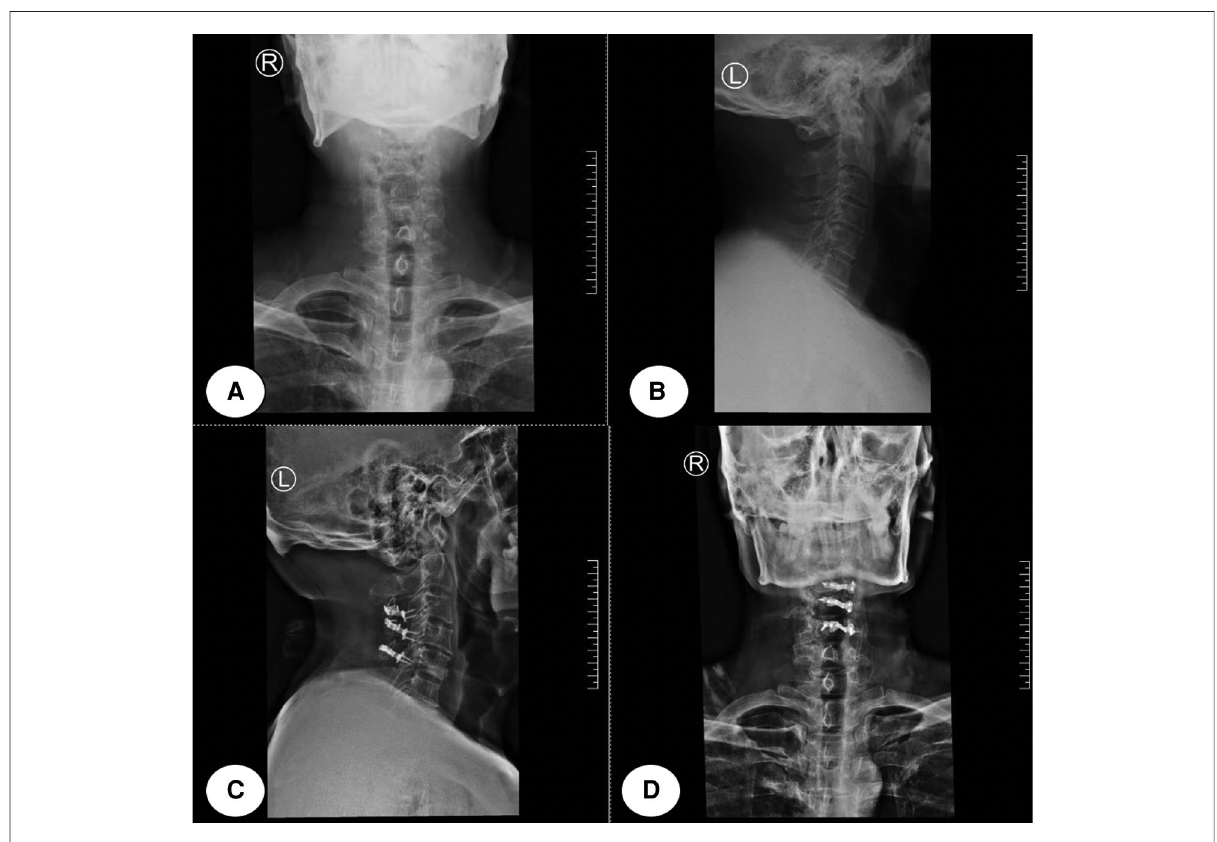
FIGURE 1 This was a typical case. A 45-year-old man was diagnosed with CSM. The VAS score was 1 before cervical posterior laminoplasty and the postoperative VAS turned to 4. [( A ) and ( B ) showed the preoperative cervical x-rays both in anterior – posterior and lateral positions; ( C ) and ( D